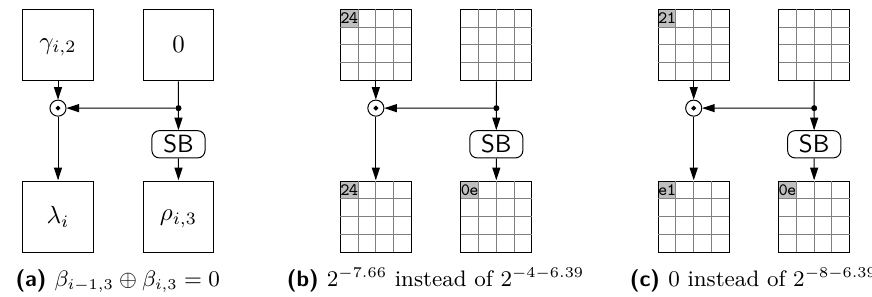
Figure 8: Examples for characteristic parts with different combined squared